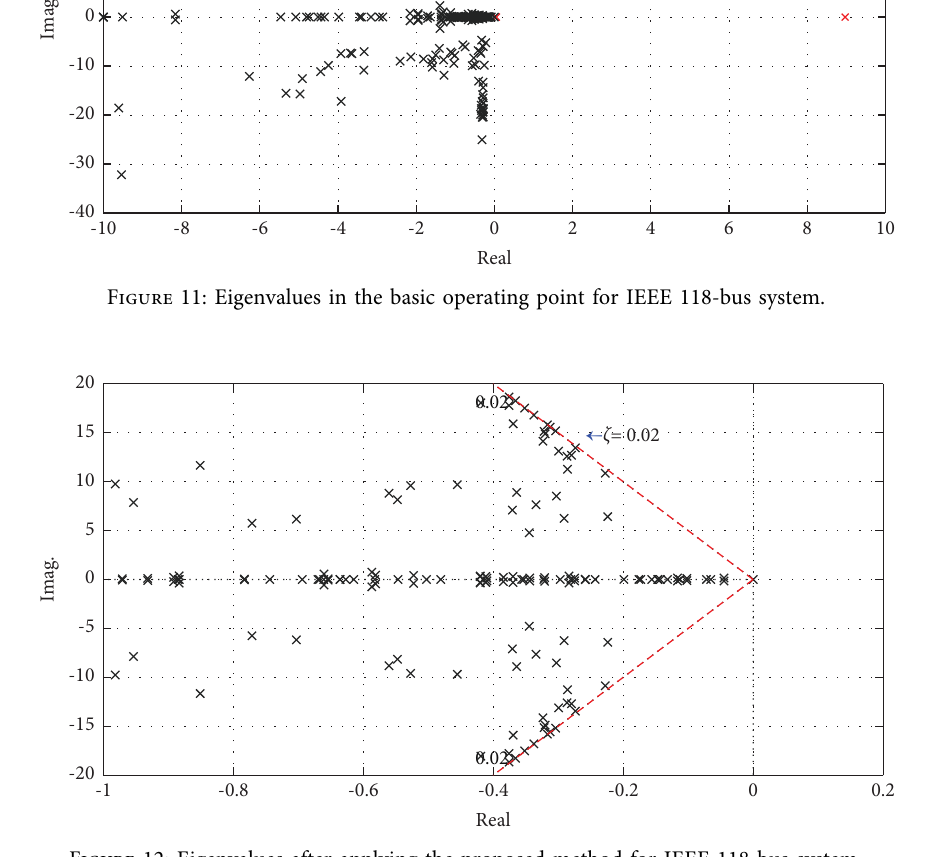
Figure 12: Eigenvalues after applying the proposed method for IEEE 118-bus system.